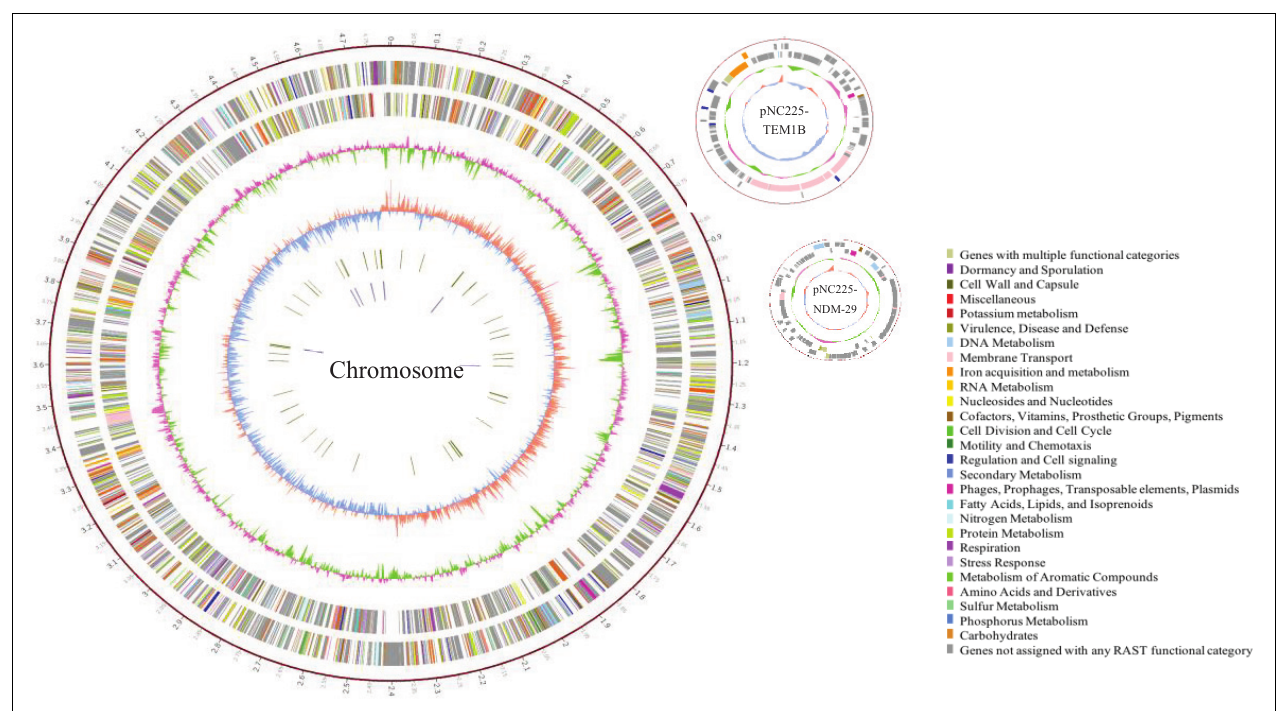
FIGURE 2 | Circular representation of 19NC225 genome (chromosome and two plasmids). The complete genome of the clinical isolate 19NC225 includes a 4,804,173-bp chromosome, a 127,534-bp plasmid (pNC225-TEM1B), and a 60,935-bp plasmid (pNC225-NDM-29). Circles are shown as follows (outside to inside): (1) A physical map scaled in megabases (Mb) from base 1 (the start of the putative replication origin); (2) coding sequences transcribed in a clockwise direction; (3) coding sequences transcribed in a counter-clockwise direction; (4) G + C content; (5) GC skew; (6) tRNA genes; and (7) rRNA genes. Genes displayed in (2) and (3) are color-coded according to different functional categories shown on the